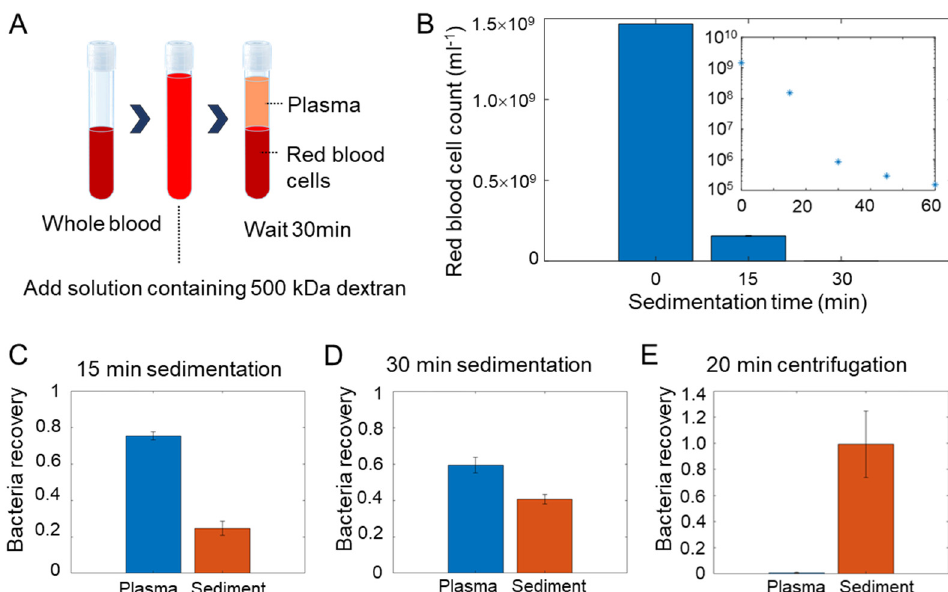
Figure 2. Dextran sedimentation for blood cell removal. ( A ) Schematic of the dextran sedimentation protocol for the removal of blood cells. ( B ) Blood cell removal efficiency. The cell count decreases exponentially with the sedimentation time. Inset, the data are plotted in semi-log scale to illustrate cell removal for several orders of magnitude. ( C , D ) Bacteria recovery (portion of total bacteria) with 15 and 30 min of dextran sedimentation. ( E ) Bacteria recovery and sample volume reduction by a soft spin at 200 g for 20 min. Data represent mean ± s.e.m. ( n = 3).